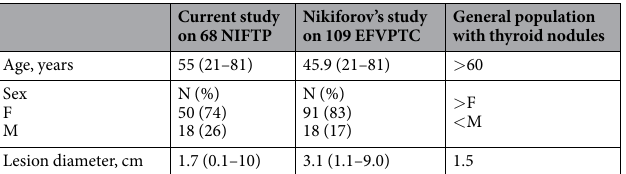
Table 1. Comparison between our study on Noninvasive follicular thyroid neoplasm with papillary-like nuclear features (NIFTP), Nikiforov et al . study on encapsulated follicular variant of Papillary Thyroid carcinoma (EFVPTC) and data of a general population with thyroid nodules, including age, sex and lesion diameter. (Age and lesion diameter are reported as mean with range value in brackets) 2,22–24 .